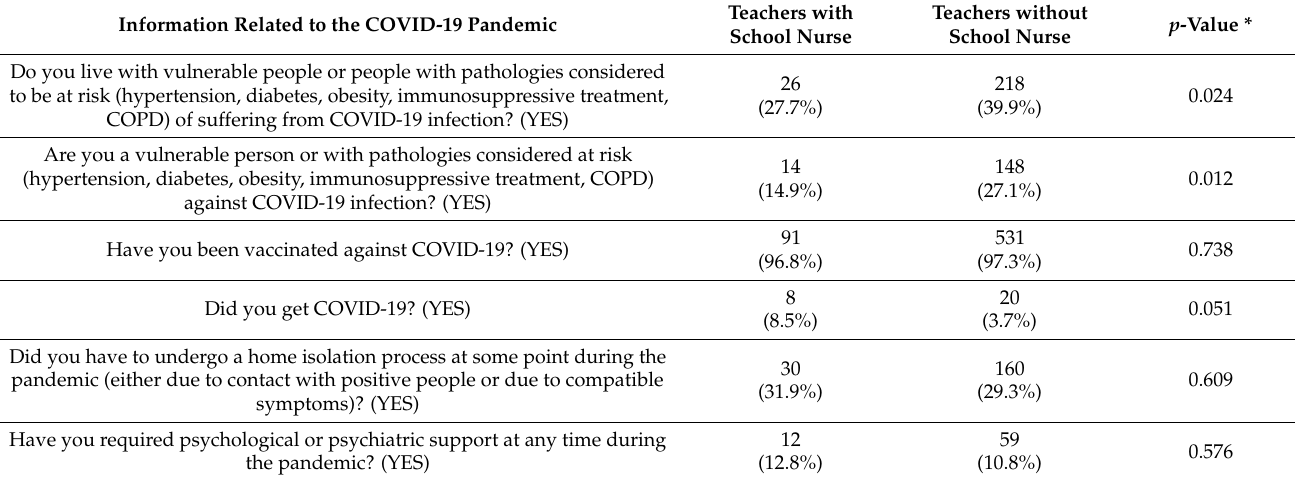
Table A3. Information regarding the COVID-19 pandemic on teachers in general and according to whether or not they have a healthcare professional in their